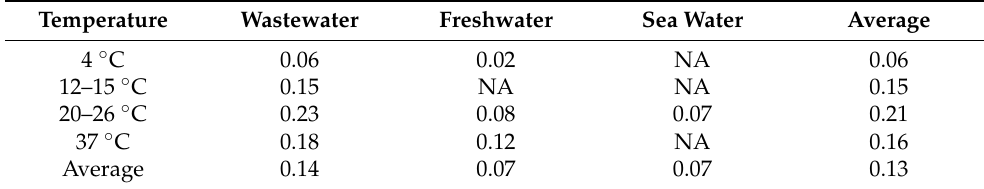
Table 5. Sensitivity ratio of predicted COVID-19 cases ( P infection ) to SARS-CoV-2 RNA decay rate constants under different conditions assuming residence time in sewers as 12